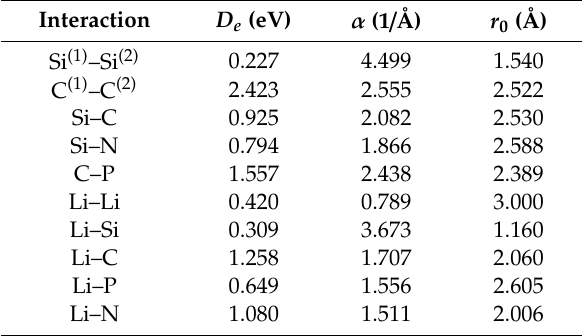
Table 3. Morse potential parameters used to describe cross-interactions, including those between Si and C atoms lying in di ff erent structural layers as well as interactions between lithium